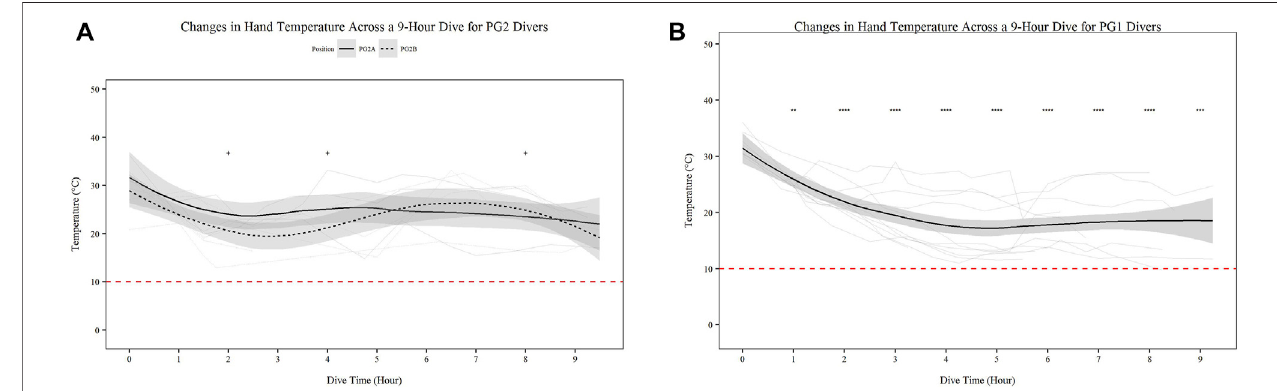
FIGURE3| ChangesinHandTemperatureacrossa9-hDiveforPG2AandPG2B (A) andPG1 (B) divers.Changesinhandtemperatureforeachdiveracrosseach dive are represented. PG2B are depicted as solid lines; and PG2A are depicted as dashed lines. The red dashed line represents the 10 ° C, the point of risk for non- freezing cold injuries. * p < 0.05, ** p < 0.01, *** p < 0.001, **** p < 0.0001; * = PG2A, + = PG2B. All comparisons are in relation to Hour 0. Trend line created using loess function with standard error band.